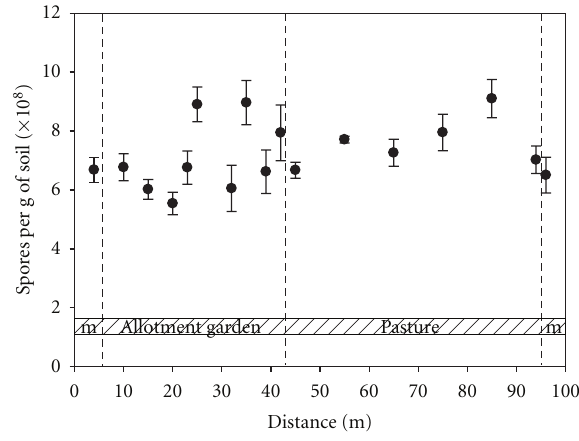
Figure 3: Transect of 100 m through a field showing di ff erent land use management: unused meadow (m), allotment garden, and pasture. Bacterial spore content is expressed as equivalents of B. subtilis . Data represent mean values of triplicates. Carbon, hydrogen, and nitrogen content (in % of dry soil) was 4 . 5 ± 0 . 6, 0 . 7 ± 0 . 1, and 0 . 3 ± 0 . 1,